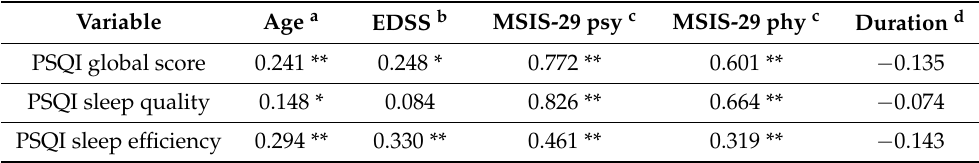
Table 5. Spearman’s rang correlations of PSQI scores with expanded disability status scale (EDSS), psychological (MSIS-29 psy) and physical (MSIS-29 phy) impact of the MS disease on the patient, and MS diagnosis duration